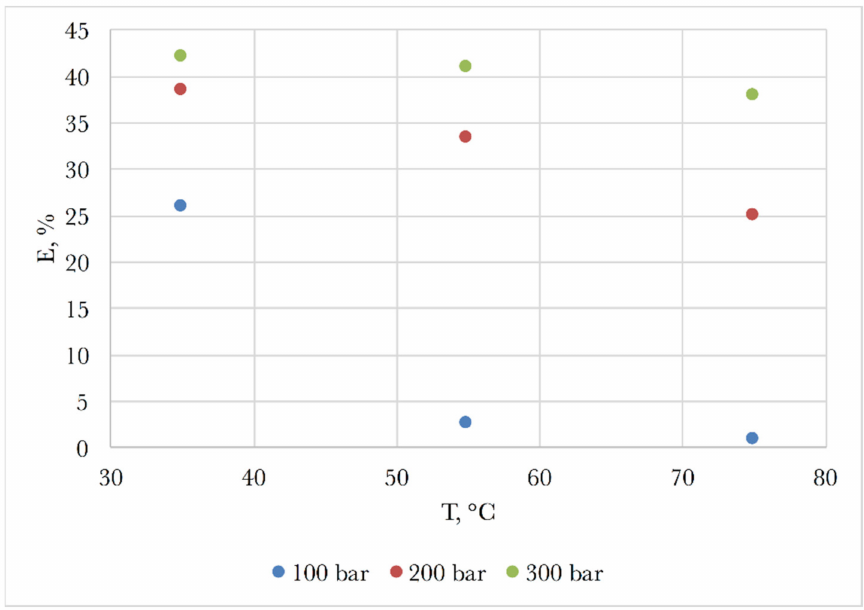
Figure 3. Dependence of benzoic acid extraction ratio on SC-CO 2 pressure and